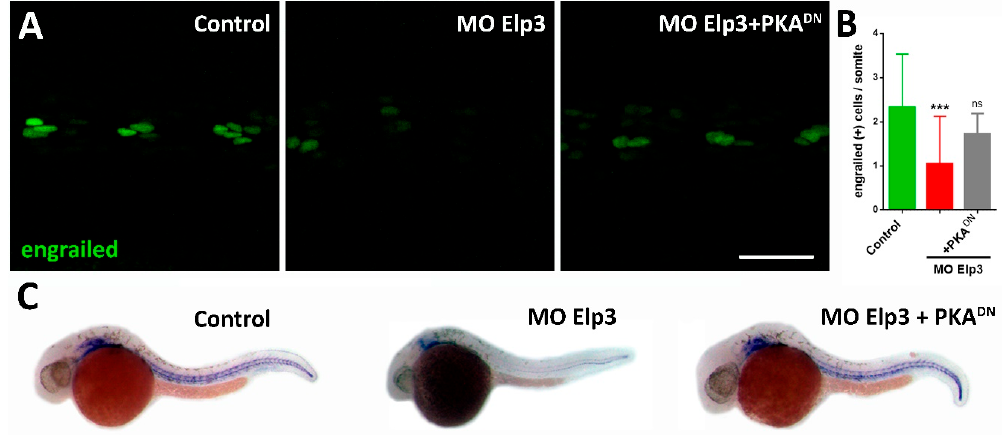
Figure 4. Shh activity is diminished in ELP morphants. ( A ) Immunohistochemistry usnig an anti- Engrailed antibody to visualize the adaxial cells. Control, elp3 morphants and MO/PKA DN mRNA- injected animals were analyzed 24 hpf. ( B ) The number of engrailed(+) cells were counted ( N = 4, n = 30, ANOVA *** p < 0.005). ( C ) In situ hybridization to detect the expression pattern of col2a1 in control, elp3 morphants and MO/PKA DN mRNA-injected fish (images representative of four independent experiments). Scale bar 40 µm.